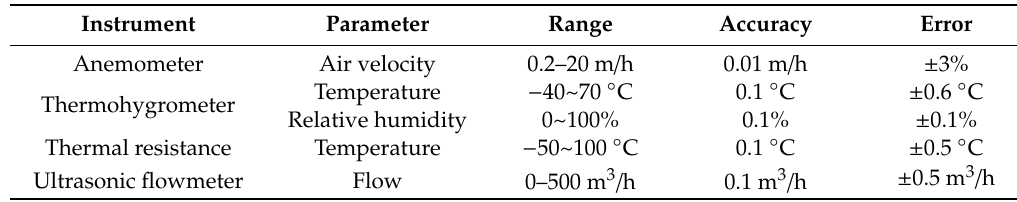
Table 1. Relevant parameters of the